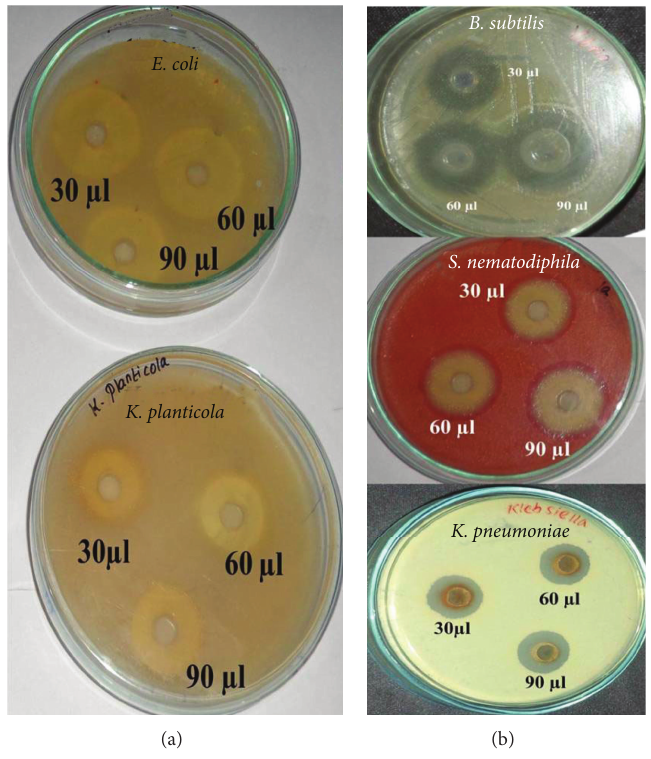
Figure 8: Antibacterial activity of silver nanoparticles against pathogens by agar well diffusion